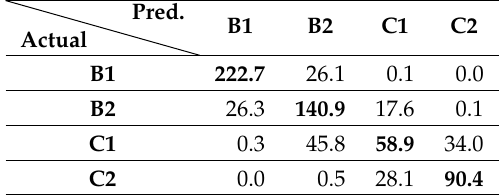
Table 6. Confusion matrix for the random forest (RF) model with features selection. Actual